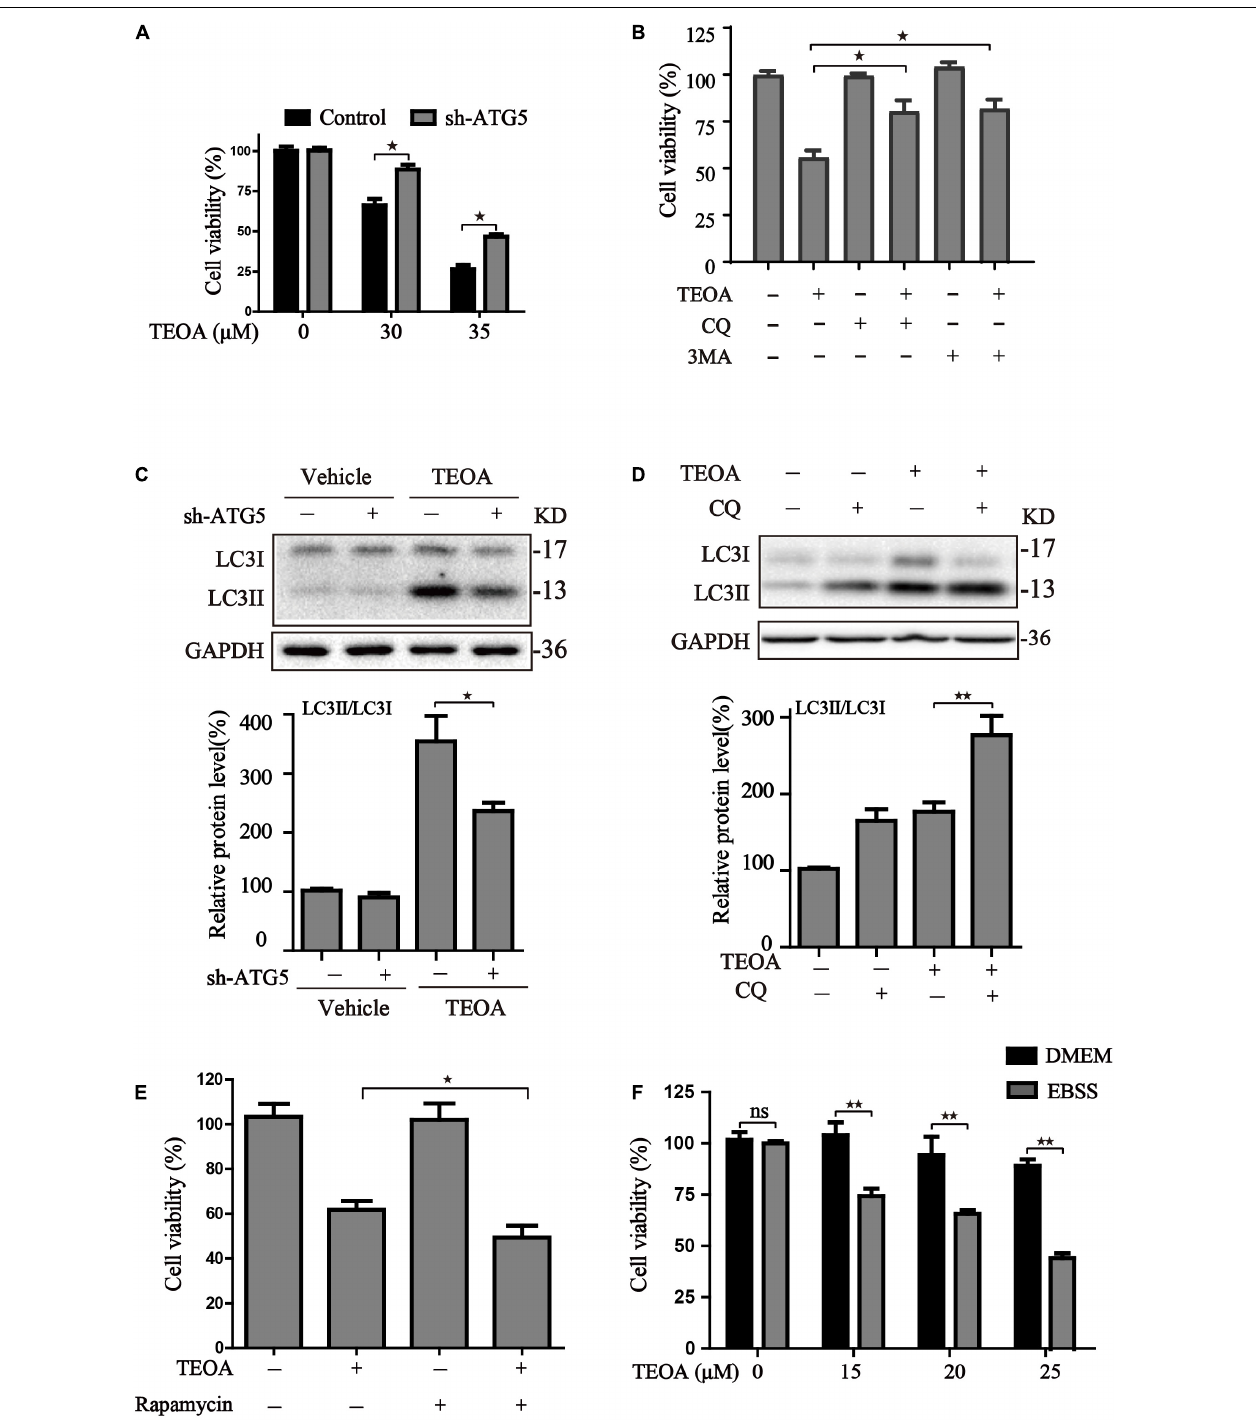
FIGURE 7 | The effects of autophagy activity on TEOA-induced cytotoxicity. (A) Control and ATG5 shRNA-transfected SW1990 cells were treated with 0, 30, 35 µ M TEOA. The cell viability was evaluated using CCK-8 assay after 12 h. (B) SW1990 cells were treated with TEOA (32 µ M) alone or combined with CQ (25 µ M), 3MA (5 mM), respectively. CCK-8 test was used to assess cell viability. (C) Control and ATG5 shRNA-transfected SW1990 cells were treated with TEOA (45 µ M) for 8 h, (D) SW1990 cells were treated with TEOA alone or combined with CQ (25 µ M), respectively, and expression of LC3 were detected by western blot, GAPDH was used as a loading control. (E) Cells were exposed to TEOA (30 µ M) with or without rapamycin (0.4 µ M) for 12 h, and then cell viability was measured using the CCK-8 assay. (F) SW1990 cells were pretreated with or without EBSS for 4 h and then incubated with TEOA for 12 h. Cell viability was measured by CCK-8 assay ( (cid:70) p < 0.05; (cid:70)(cid:70) p < 0.01, versus control).